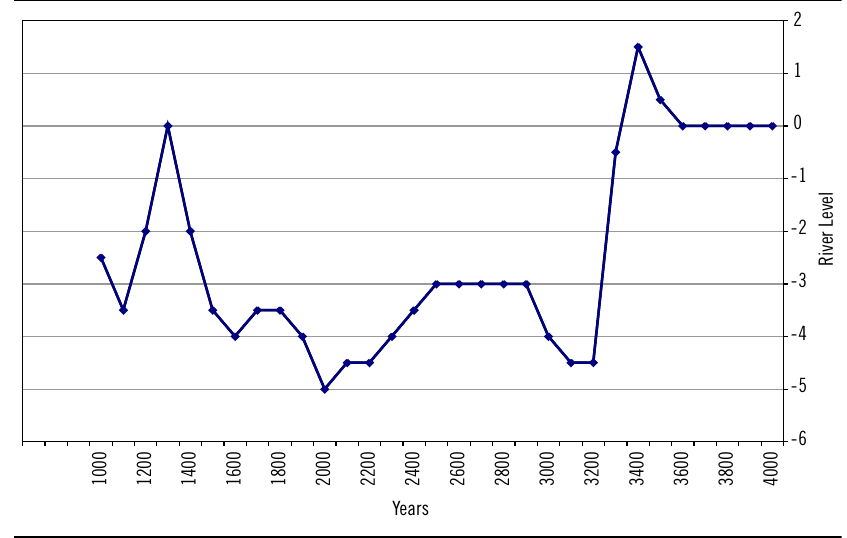
Figure 4 – Tigris-Euprates River